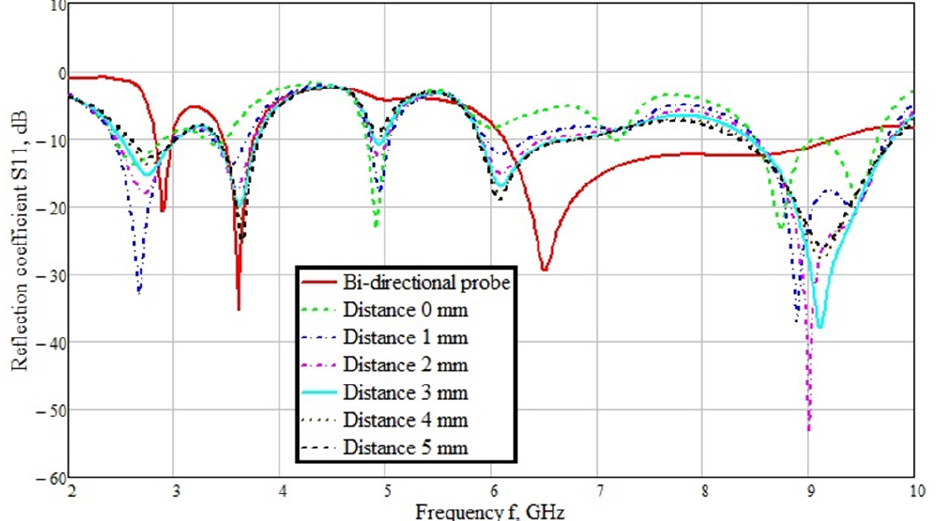
Figure 6. Frequency dependence of the reflected signal from change in the distance between the metal plate and the